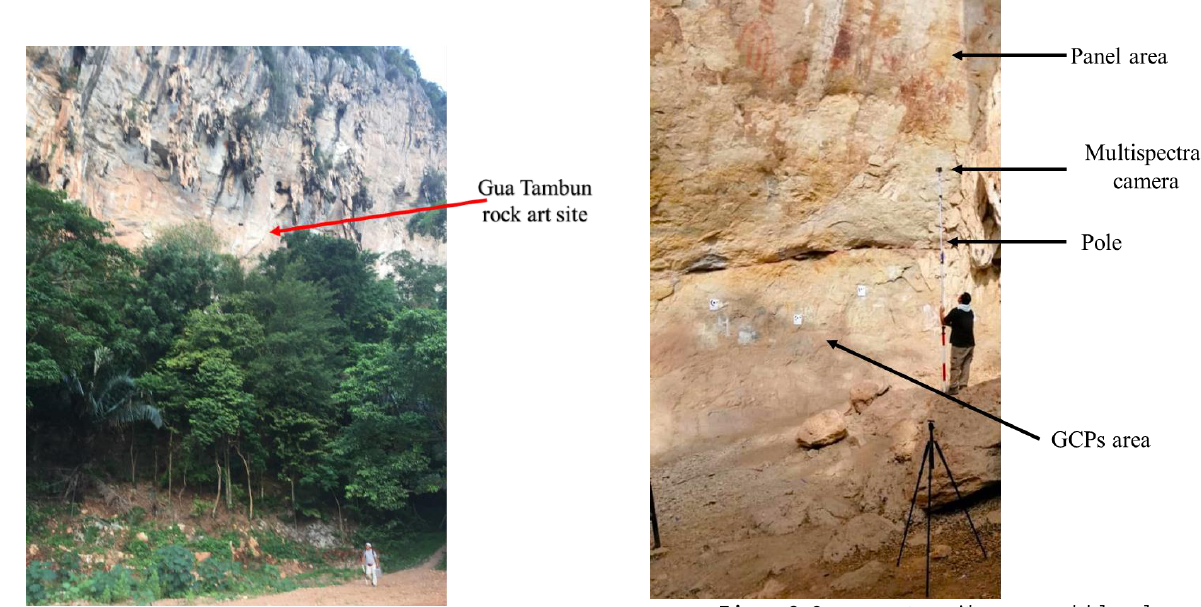
Figure 1. Gua Tambun rock art site. Figure 2. Camera setup with an expandable